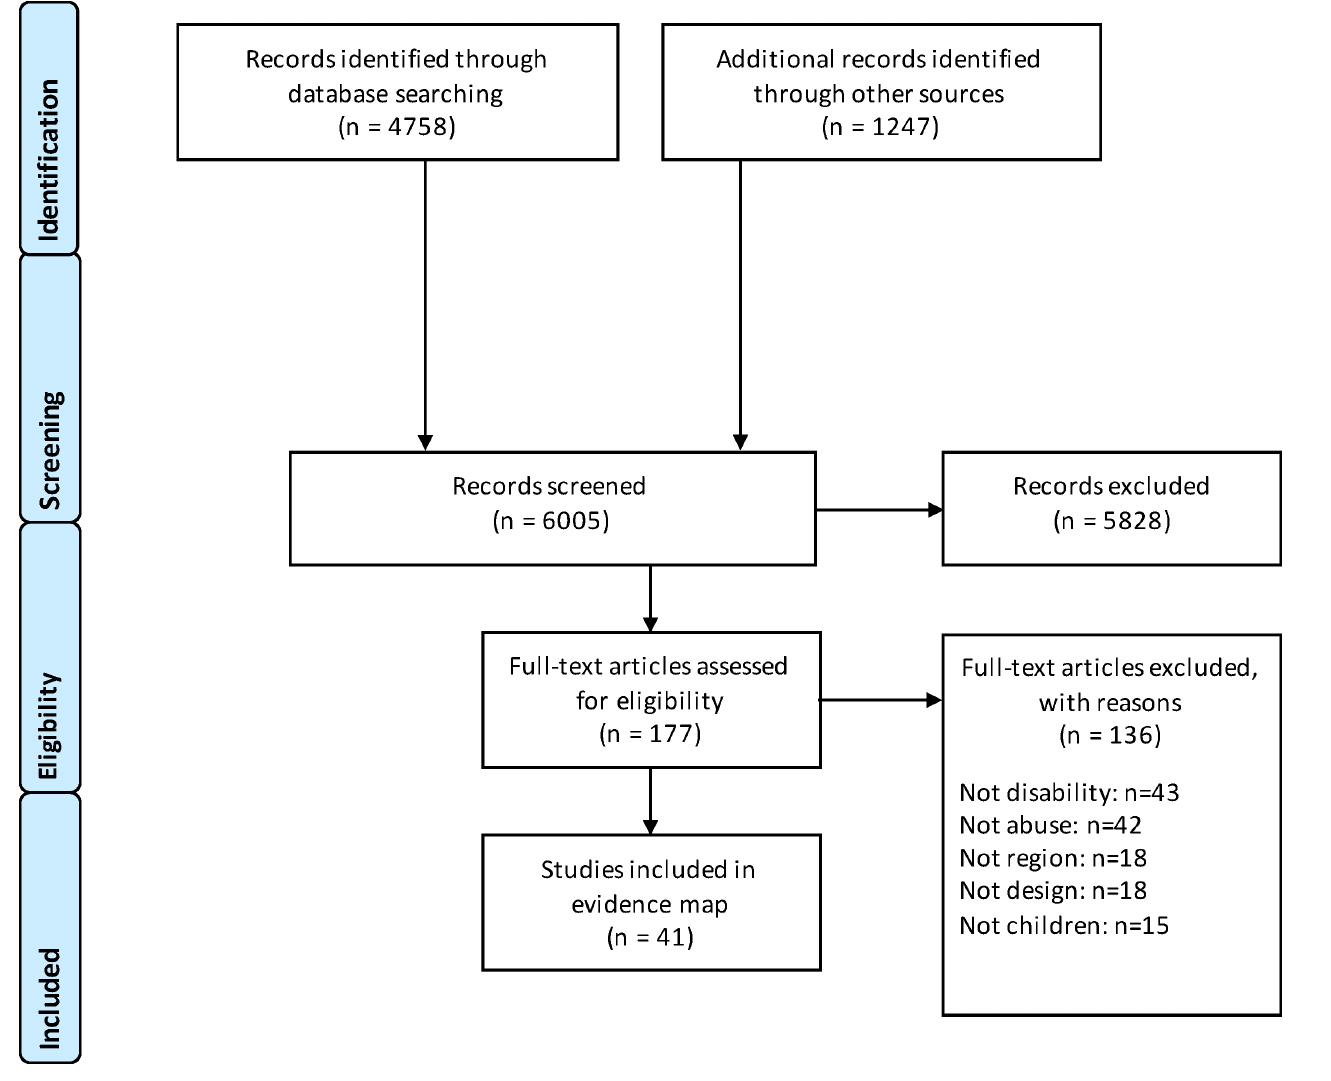
Fig 1. Prisma diagram.